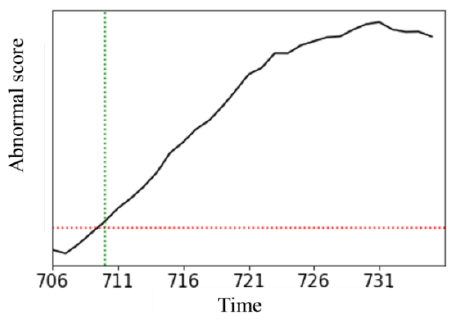
Figure 18. Fault detection when t = 710 min in Mode 4.